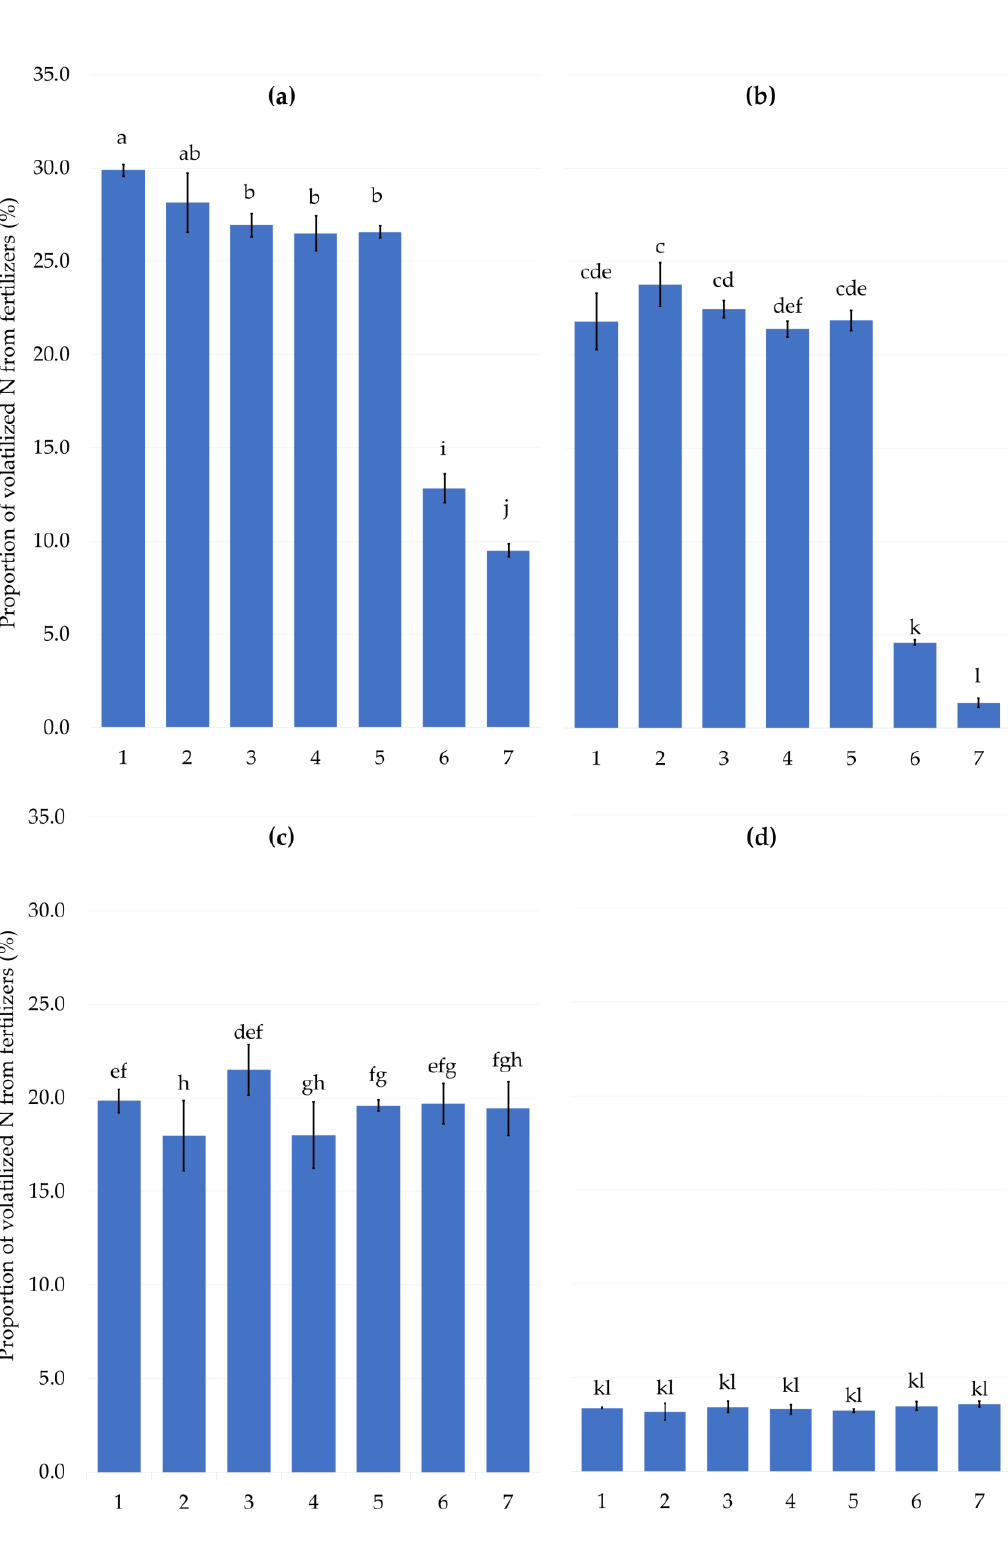
Figure 1. Proportion (%) of volatilized nitrogen from fertilizers ( a ) UAN, ( b ) urea solution, ( c ) solu- tion of AS and ( d ) solution of AN. Experimental treatments: (1) fertilizer without additive, (2) fer- tilizer + acid NHA (100:1), (3) fertilizer + neutral NHA (100:1), (4) fertilizer + acid NHA (100:2), (5) fertilizer + neutral NHA (100:2), (6) fertilizer + NBPT and (7) fertilizer + StabilureN 30. The columns represent the mean ( n = 4); error bars present the mean standard deviation. The same letters at the top of the columns describe no statistically significant differences between the treatments (Tukey’s test, p ≤